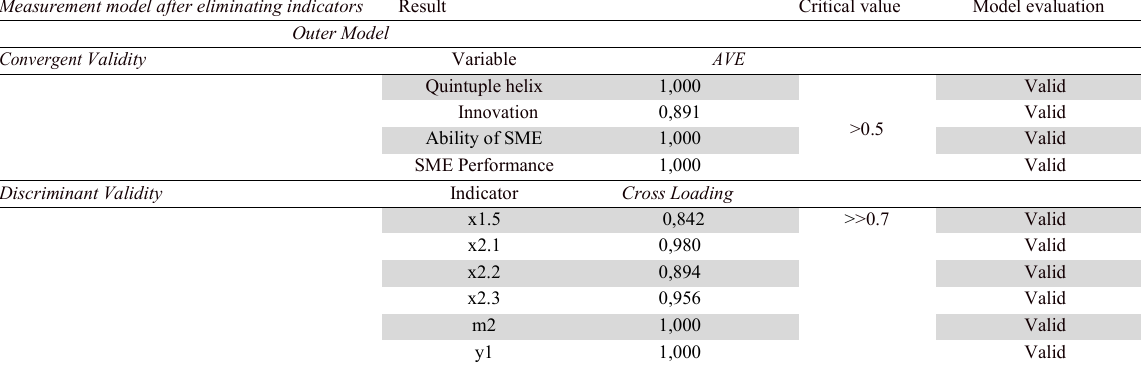
Measurement fit model Indonesia craft sub sector Measurement model after eliminating indicators